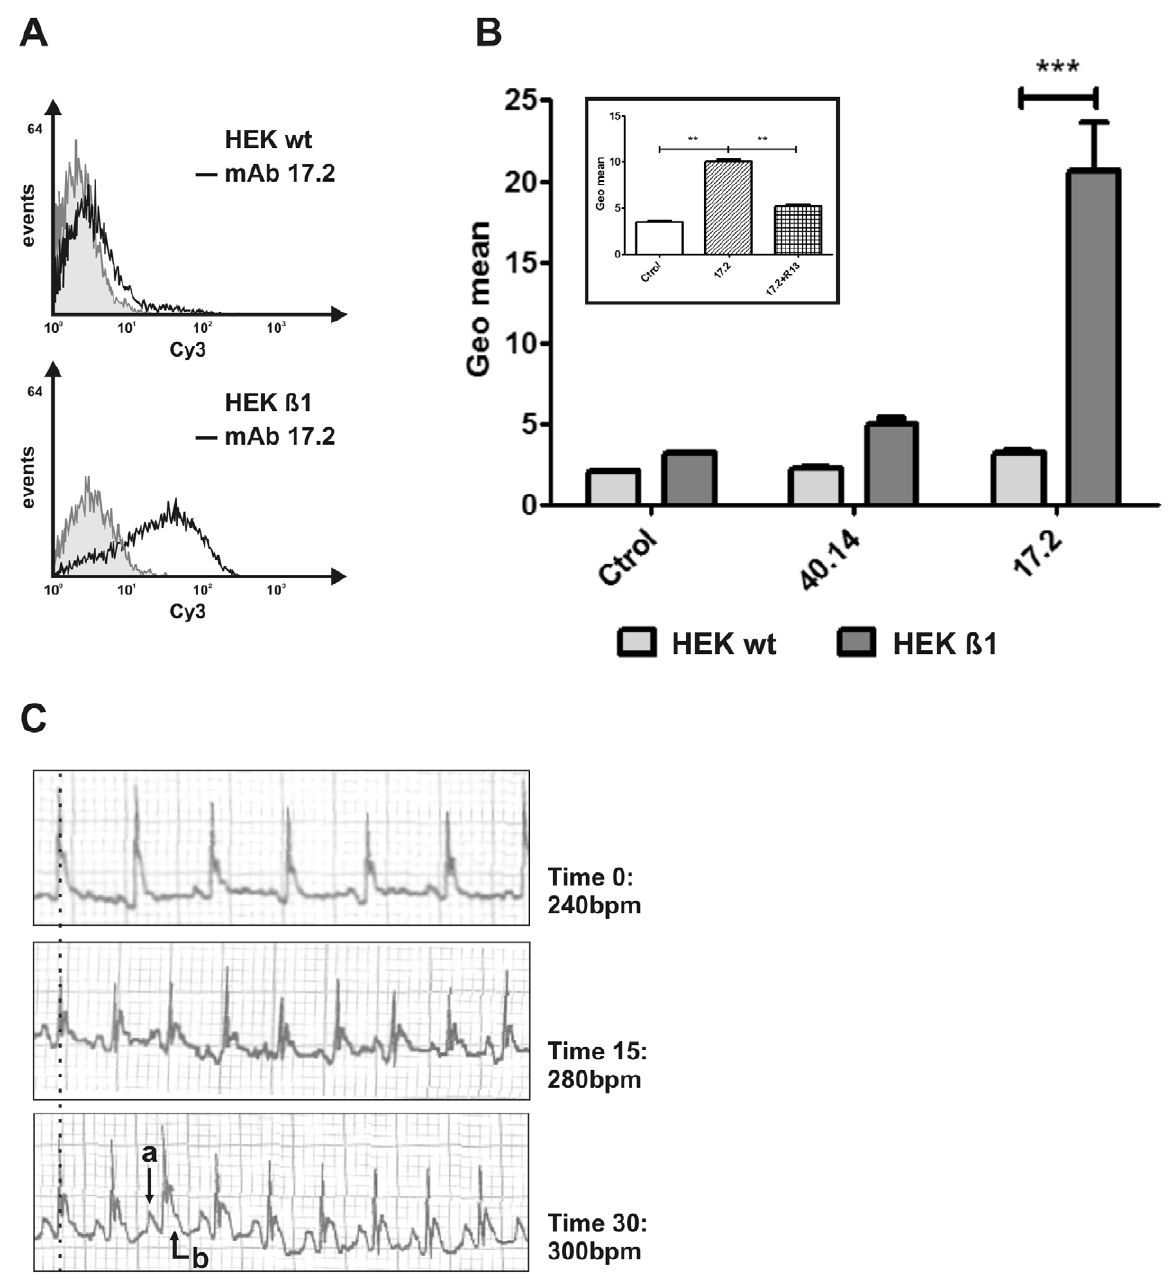
Figure 3. Functional activity of the mAb 17.2. A. Representative histogram showing the HEK and HEK- b 1 cells labelled with mAb 17.2 followed by a Cy3-conjugated goat anti-mouse IgG. B. Results are expressed as means 6 SD (n=3). Inset: Binding of mAb 17.2 to HEK- b 1 cells in the presence of R13 peptide. ** p , 0.01; *** p , 0.001. C. Passive transfer of mAb 17.2 to naı¨ve mice. Repolarisation abnormalities (a) and first degree AV conduction block (b) are indicated by arrows. bpm: beats per minute. loop (2ECL) of the model to allow positioning the Ab on the putative binding site ( Figure 4A ) and the complex was subjected to a two minimization steps followed by heating, equilibration and production protocols under a distance-dependent, dielectric- implicit solvent model ( Figure 4B ). The interaction energy of the complex Ab- b 1-AR was estimated at 2 430 kcal/mol. Polar contacts found in the model are summarized in Table 3 . Some of Ab residues identified in the interaction with the humanized 2ECL peptide were key residues in the interaction with the T. cruzi